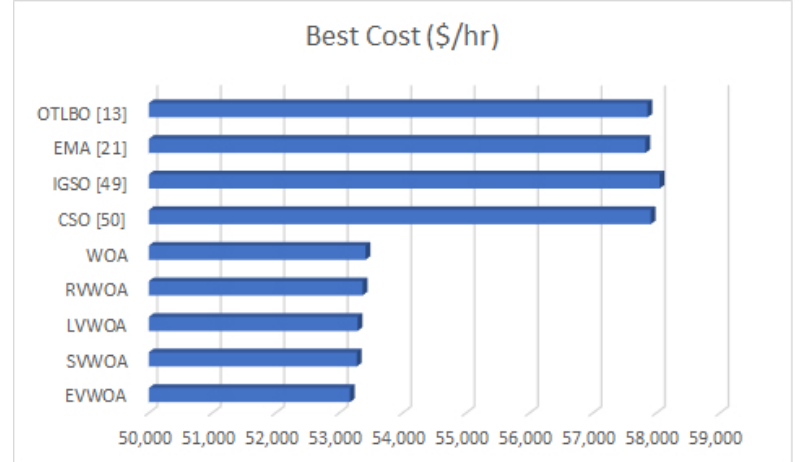
Figure 12. Best Cost Comparison for Case Study 4.